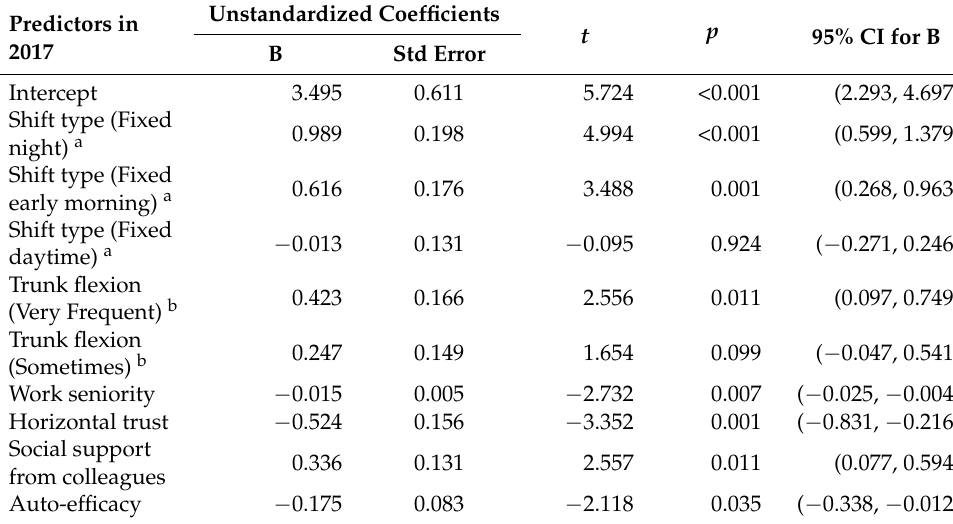
Table 7. Multiple linear regression model results for the dependent variable sleep disturbance in 2017 and